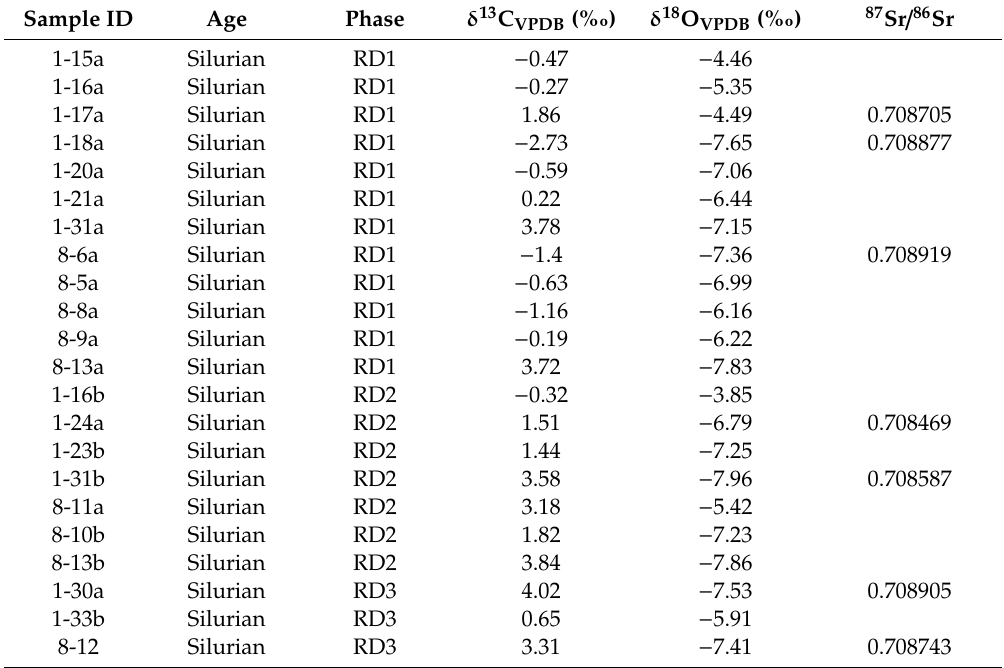
Figure 10. Cross plot of δ 13 C vs δ 18 O of di ff erent types of dolomite in Silurian and Devonian formations. The data shows an overlap between δ 13 C and δ 18 O values in Silurian and Devonian dolomites. In both age groups, δ 13 C values fall in the range of values estimated for the marine calcite of equivalent age except for the more negative values in some Silurian RD1 samples possibly related to bacterial sulfate reduction (BSR). The negative shift in δ 18 O values, more pronounced in Silurian dolomites, can be related to dolomite recrystallization during burial and increasing temperature. The green box represents isotopic values of the Middle Devonian marine calcite [49] and the yellow box represents the estimated isotopic values for the Silurian marine dolomite [50]. Table 3. Oxygen and carbon stable isotopes, Sr isotopes results from dolomite and calcite